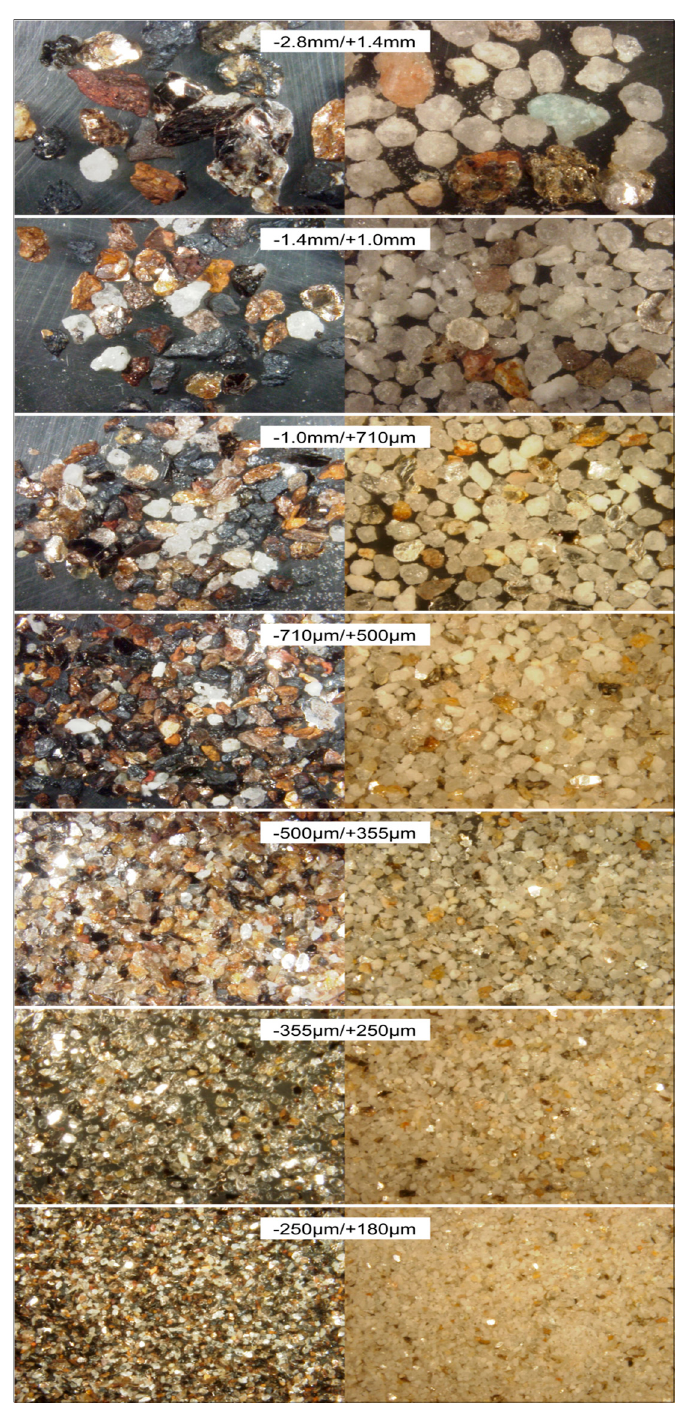
Figure 3. Photographs of sink and float products side by side for comparison, across all size fractions. All photos were taken under 6 × magnification.